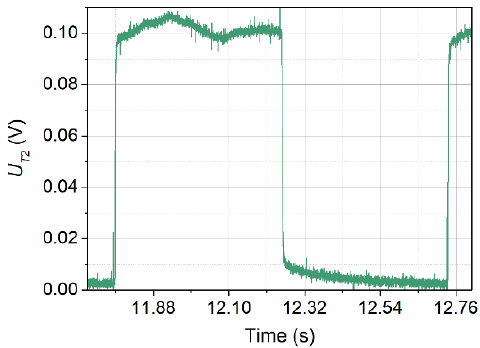
Figure 7. The shape of the pulse recorded by detector T2 for the thermal wave frequency f = 1 Hz and the inflow velocity v ∞ = 1.97 m/s.